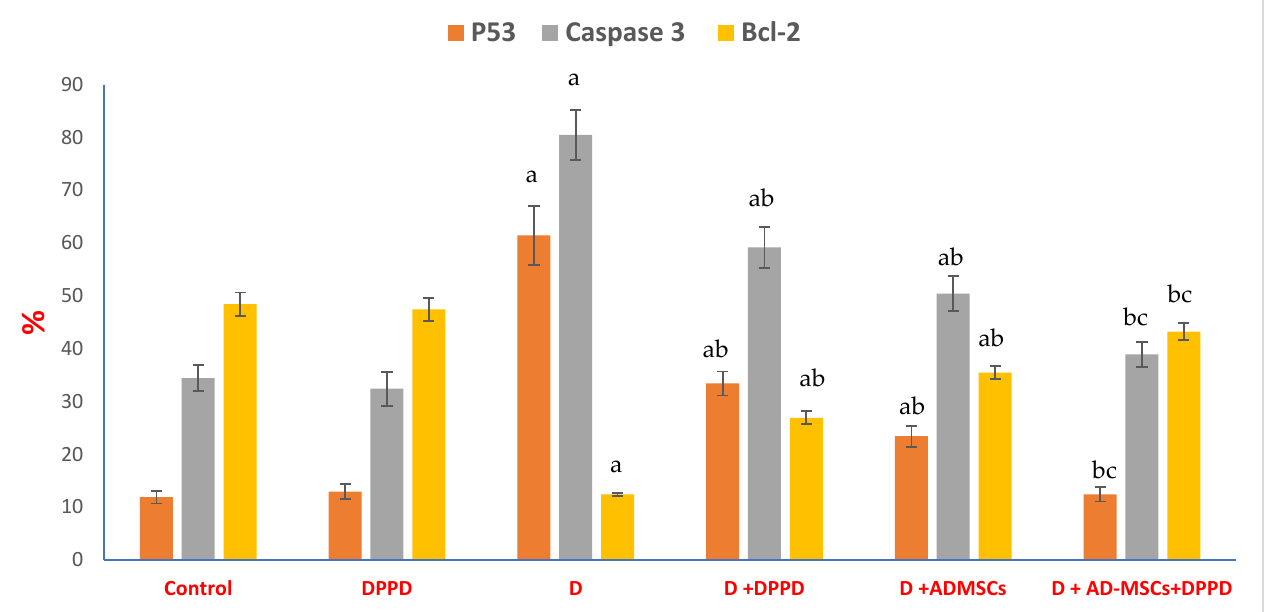
Figure 6. Pancreatic T-Helper (CD 4) and T-Cytotoxic (CD 8) %. Values expressed as ± SEM ( n = 6). a, b & c are Significant differences ( p ≤ 0.05) compared to control, diabetic untreated and DPPD ‐ diabetic treated groups, respectively. % is the percent of change compared to the diabetic group.